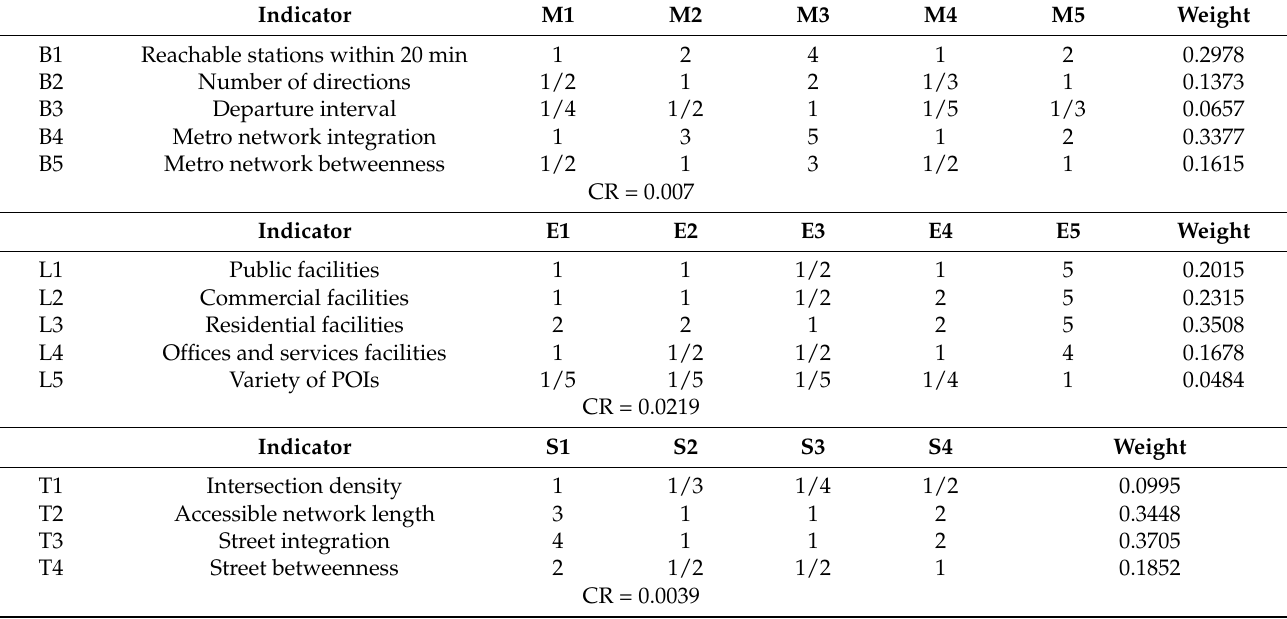
Figure 2. The evaluation hierarchy and determined weights of each indicator by AHP. Table 2. Pairwise matrix and ranking of indicators.